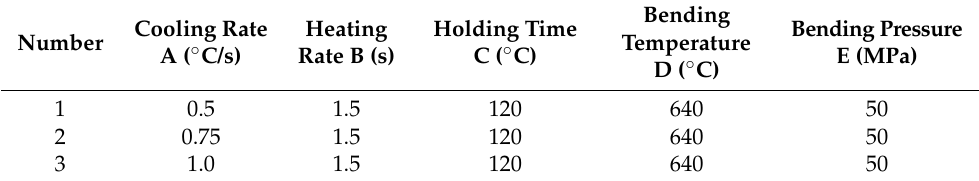
Table 4. Parameter setting of cooling